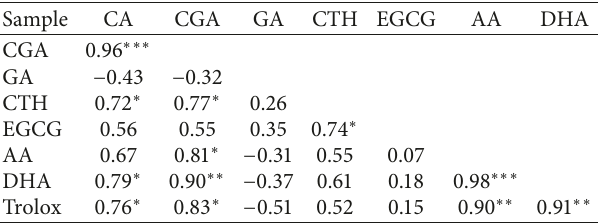
Table 4: The values of Pearson correlation coefficient for corre- lation among AOPs of investigated antioxidants determined in all variants of ABTS, DPPH, and FC assays.